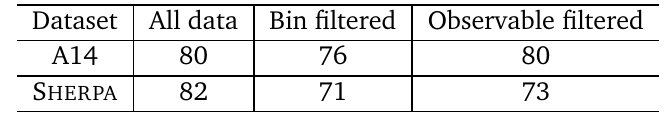
Table 18: Best µ obtained for A14 and S HERPA datasets when unfiltered ( All data ), bin filtered and observable filtered data are used for parameter